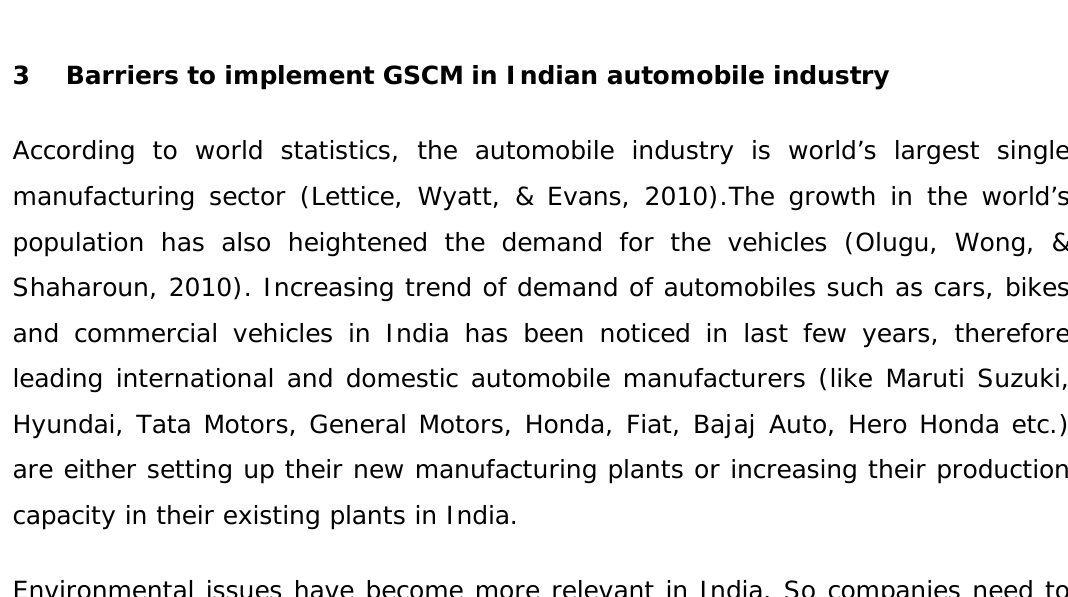
Table 1. “Difference between the Green Supply Chain Management and Conventional Supply Chain